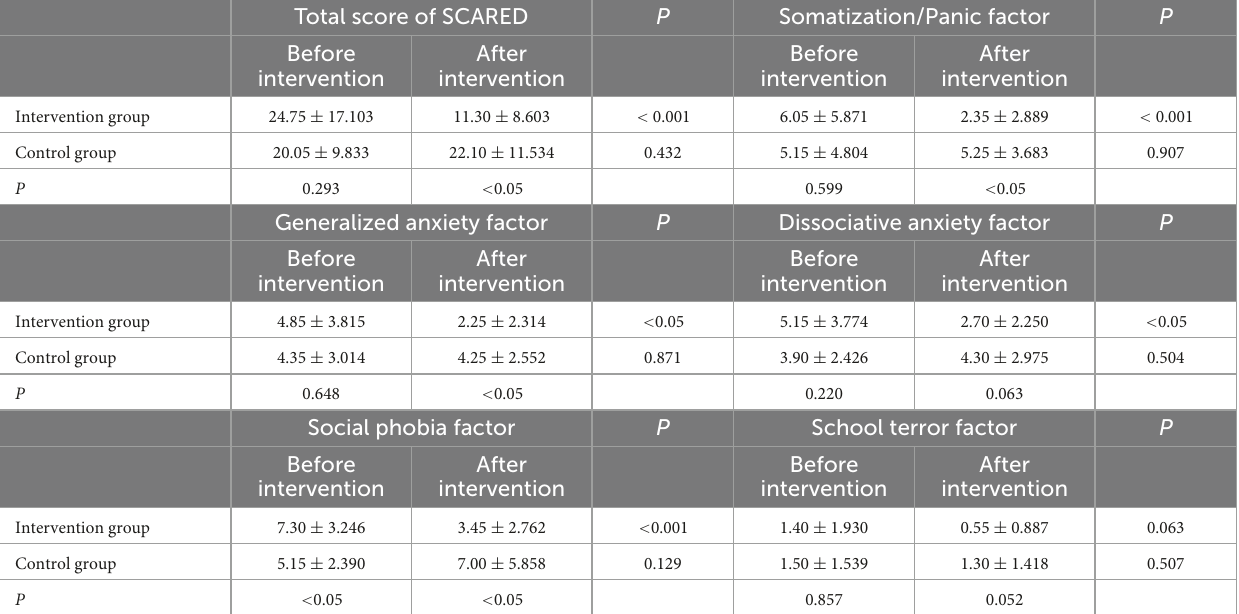
TABLE 3 Screening for children’s anxiety disorders (SCARED) scale score comparison between the intervention and control groups. Total score of SCARED P Somatization/Panic factor P Before After Before After intervention intervention intervention